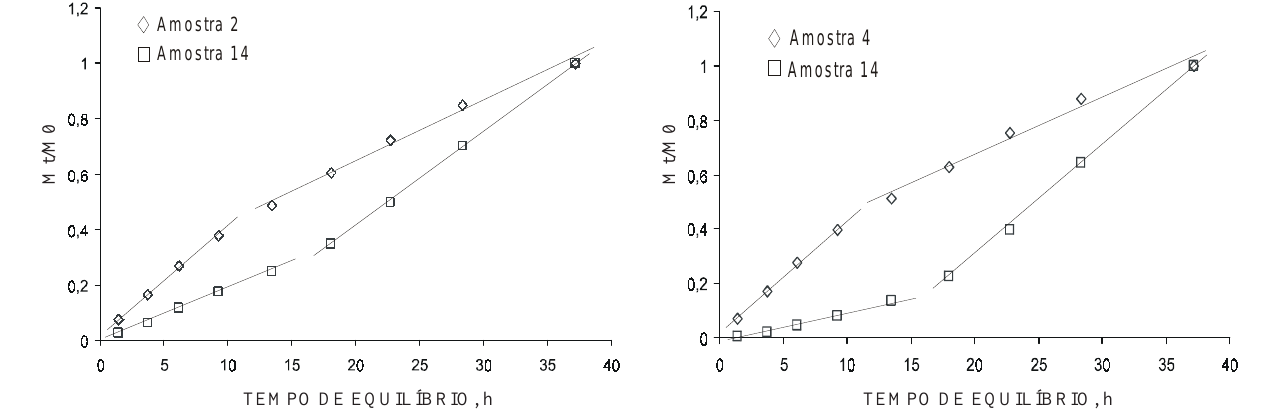
Figura 1. Cinética de liberação de K da fração argila do horizonte Bw do Latossolo Vermelho distrófico típico (amostra 2) e do horizonte BC do Argissolo Vermelho-Amarelo eutrófico abrúptico (amostra